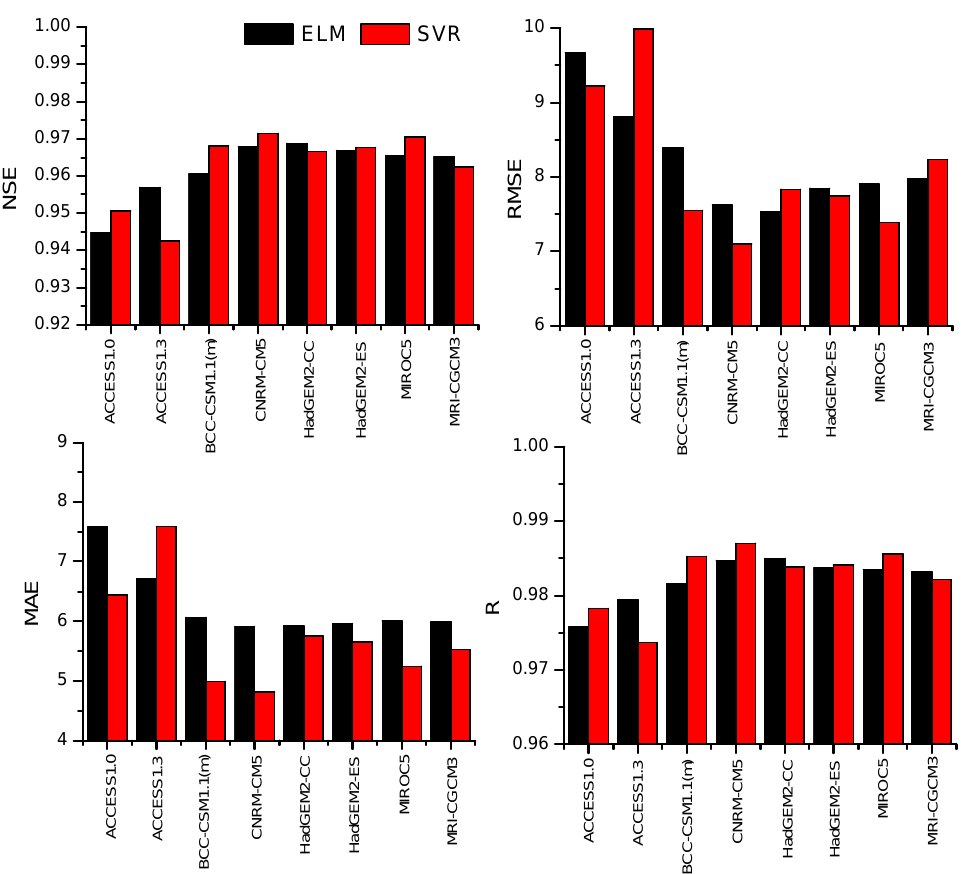
Figure 4. Performances for the ELM and SVR models applied to the eight GCM outputs for downscaling the ET 0 in validation period (1990–2005).